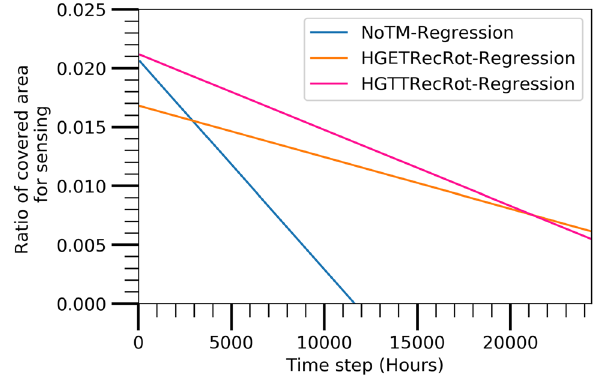
Figure 14. Covered sensing area based on prediction model.